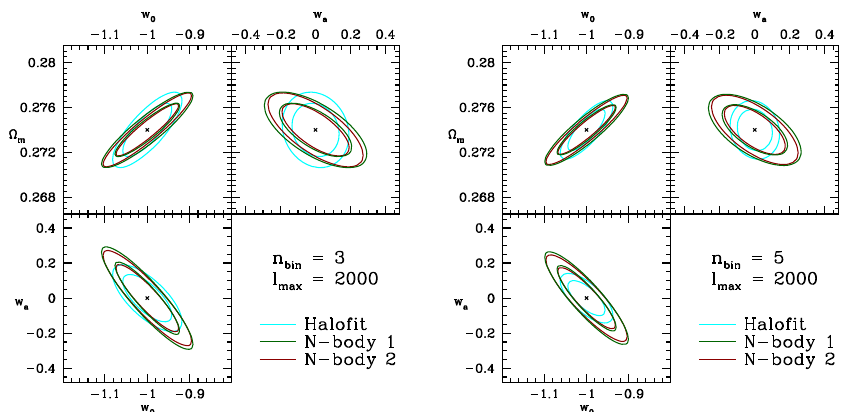
Fig. 27 Likelihood contours, for 65 and 95% C.L., calculated including signals up to (cid:23) (cid:7) 2000 for the Λ CDM fiducial. Here simulations and halofit yield significantly different outputs